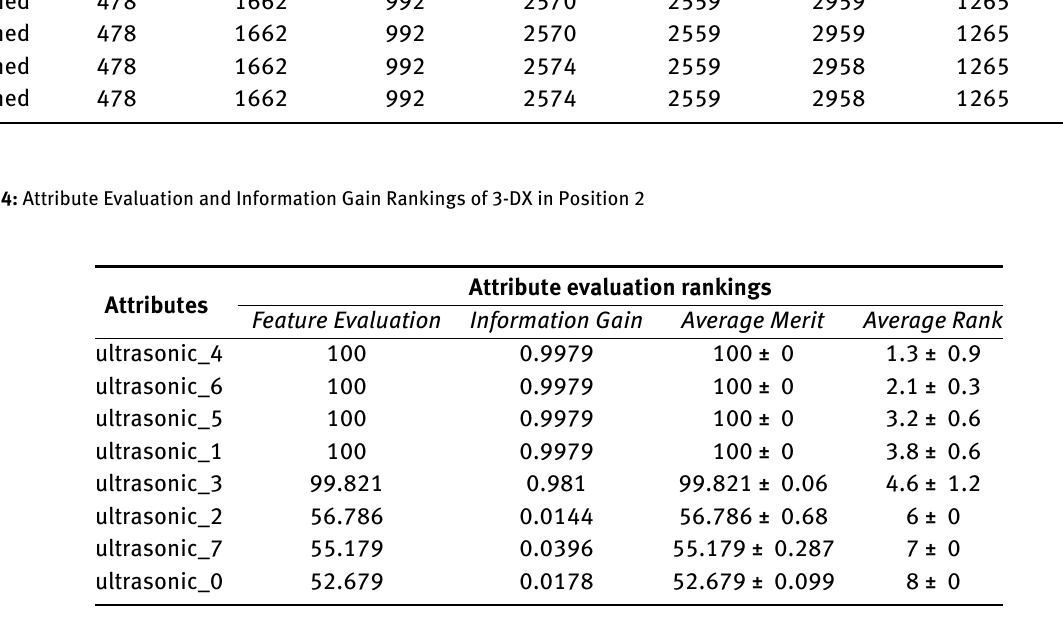
Table 5: Attribute Evaluation and Information Gain Rankings of X80-H in Position 5